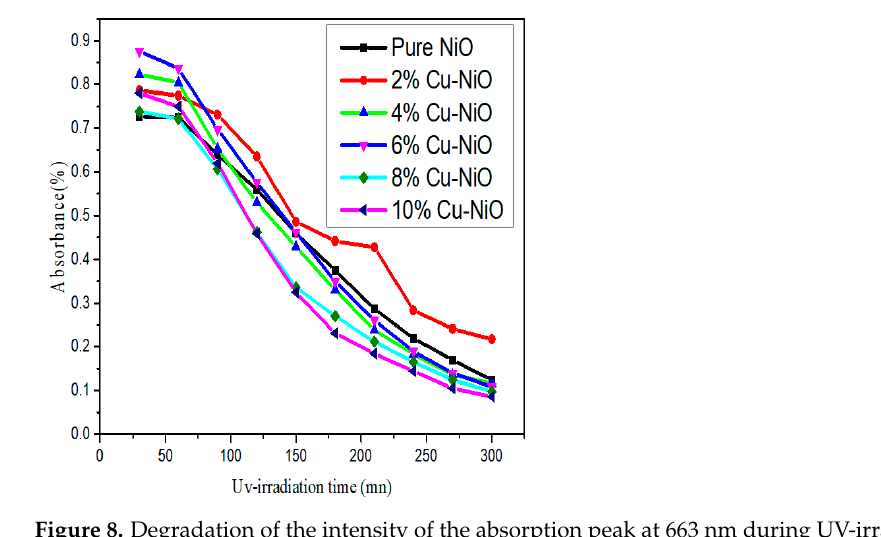
Figure 8. Degradation of the intensity of the absorption peak at 663 nm during UV-irradiation